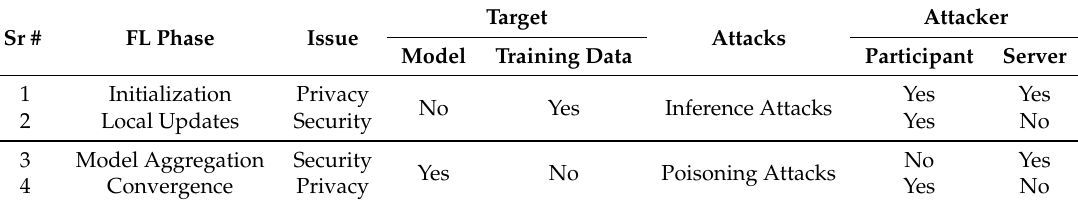
Table 2. Properties of federated learning phases with respect to privacy and security